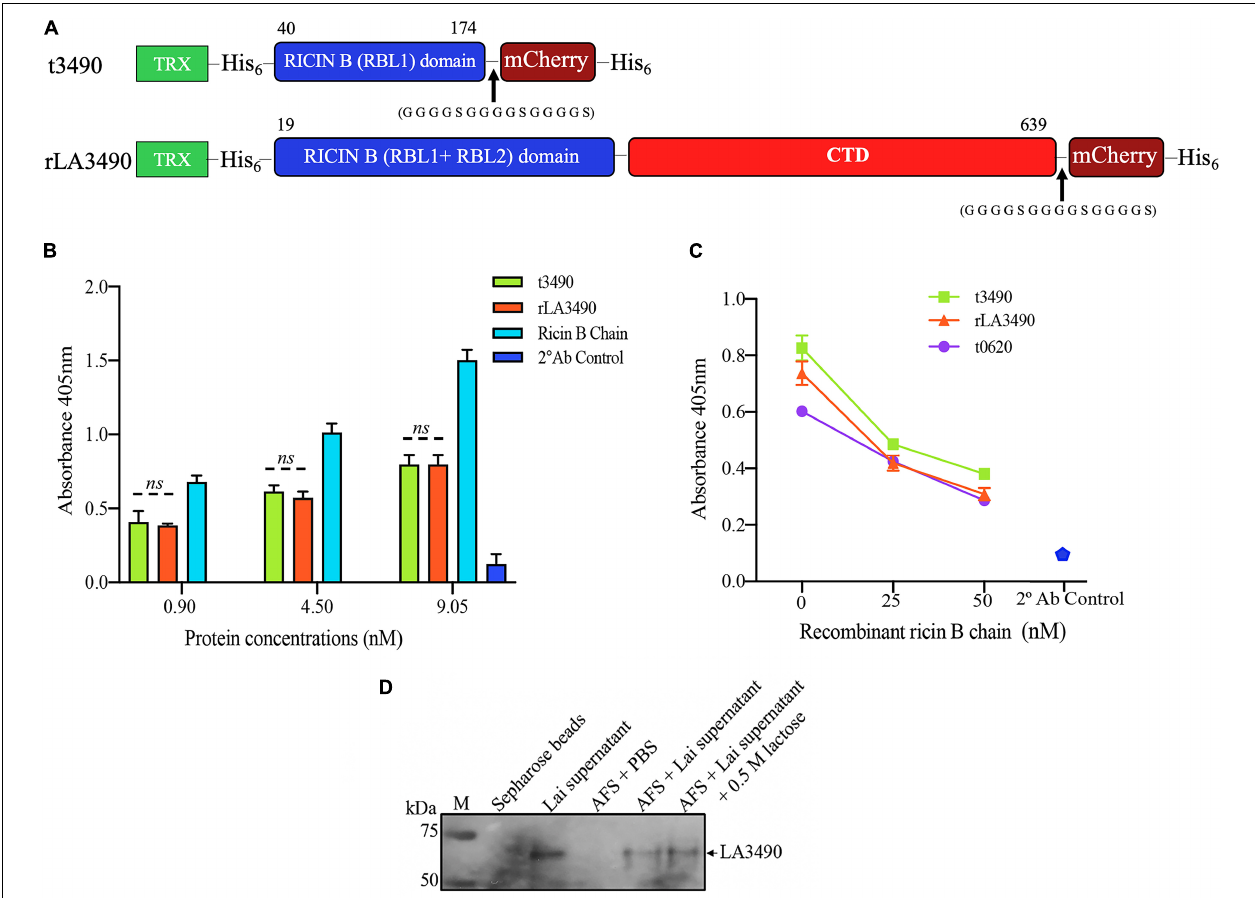
FIGURE 3 | VM Protein LA3490 is a bona fide R-type lectin. (A) Schematic depicting the organization of the recombinant mCherry (mC) fusion proteins used in the current study; t3490, amino acid positions 40–147 aa (minus SS, signal sequence); and rLA3490, 19–639 aa, also lacking SS. Recombinant fusions also include a glycine–serine (GGGGSGGGGSGGGGS) linker and C-terminal His 6 tag (purification), and N-terminal thioredoxin. RBL and CTD denominates ricin B-like lectin and carboxy terminal domain, respectively. (B) Asialofetuin-binding assay demonstrating that truncated (t3490) and full-length (rLA3490) VM proteins bind to asialofetuin in a dose-dependent manner similar to commercially available ricin B chain. (C) Competition assay showing that truncated (t3490), the ricin B domain of another VM protein, LA0620 (t0620), and full-length (rLA3490) compete for the same binding site as recombinant ricin B chain (25 nM and 50 nM). Assays were performed in microtiter plates using an ELISA format. Mouse polyclonal anti-LA3490 and anti-LA0620 antibodies (1:1,000 dilution) were used as primary and anti-mouse IgG as secondary antibody (used alone as a specificity control, labeled as 2 Ab control). (D) Native LA3490 (70.29 kDa) secreted by L. interrogans serovar Lai into EMJH culture supernatant in the presence of 120 mM NaCl binds to asialofetuin-coupled Sepharose beads (AFS). Proteins were eluted with 0.5 M lactose. Unconjugated Sepharose beads incubated with L. interrogans serovar Lai-conditioned medium, and AFS beads with PBS served as controls. Assays were run in triplicate, and experiments were repeated twice. The mean absorbance ( ± SEM) was visualized in GraphPad Prism 8 and considered statistically significant at p < 0.05. The blot shown in panel (D) was cropped from the full blot shown in Supplementary Figure 3